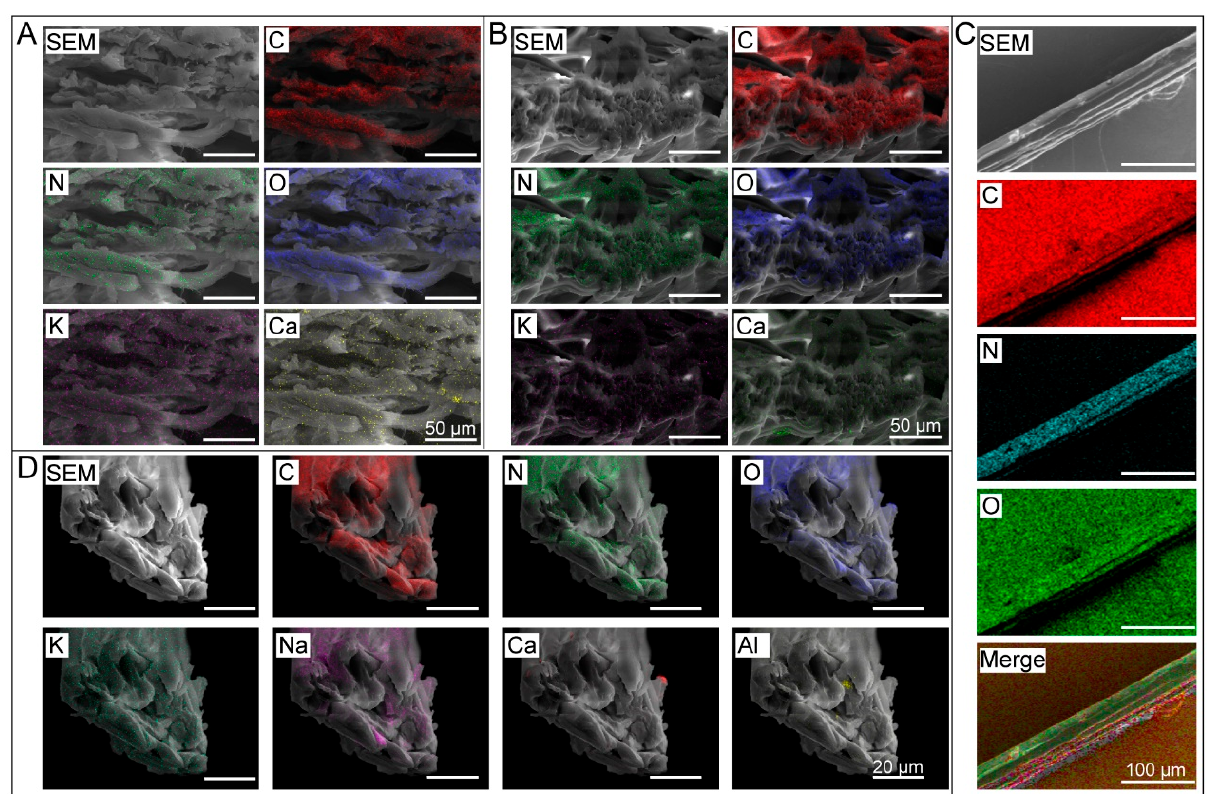
Figure 3. Analysis of metal elements in the cocoon layer and silk fiber. ( A ) Distribution of elements in a cross-section of cocoons of 872 strains, ( B ) Distribution of elements in a cross-section of cocoons of Bombyx mandarina ; ( C ) Distribution of elements in a cross-section of raw silk; ( D ) Longitudinal element distribution of the silk fiber.